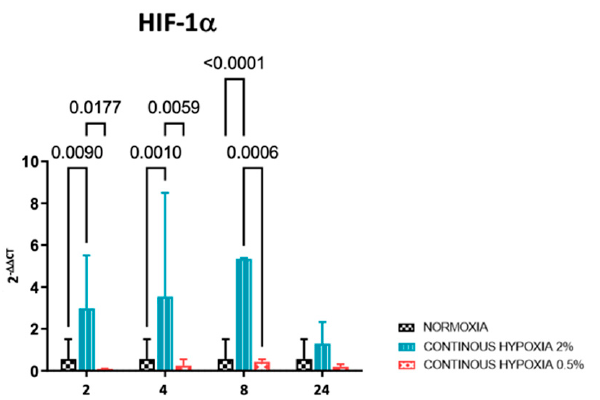
Figure 2. Relative mRNA expression of HIF-1 α. Total RNA was extracted, and qRT-PCR was performed in order to quantify HIF-1 α . β -actin was used as internal normalizer. Data represent the mean ± SD. * p < 0.05. The p is shown only if there is a significant expression difference.